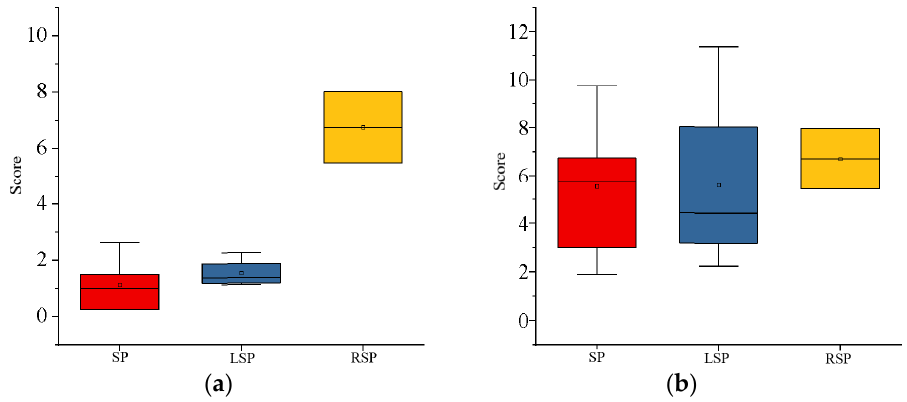
Figure 9. Subjective sleep-quality graph of subjects with three different sleeping-position preferences: ( a ) the difference in morning and evening sleepiness (KSS score); ( b ) the fatigue state (MS score).